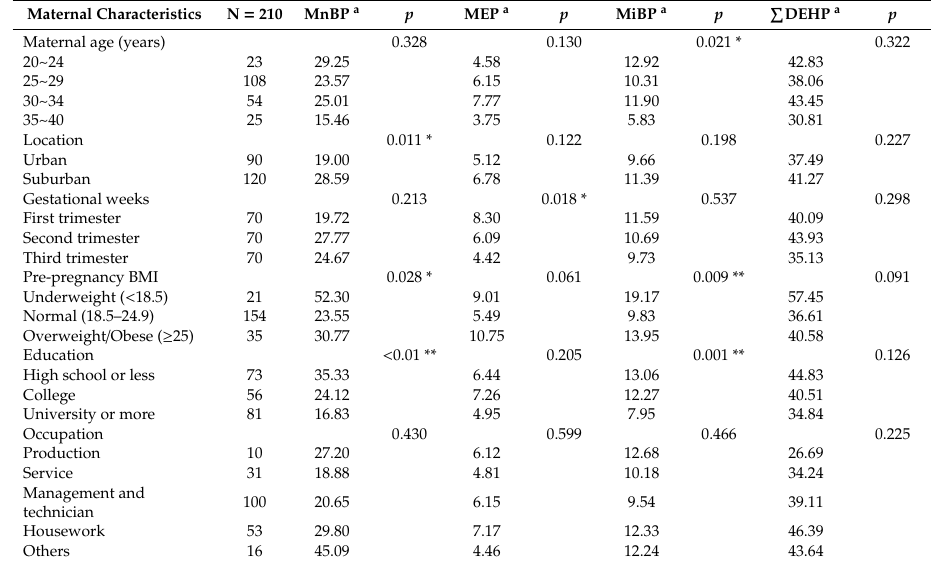
Table 3. Univariate analysis of urinary phthalate metabolites (geometric mean) based on the maternal demographic characteristics.